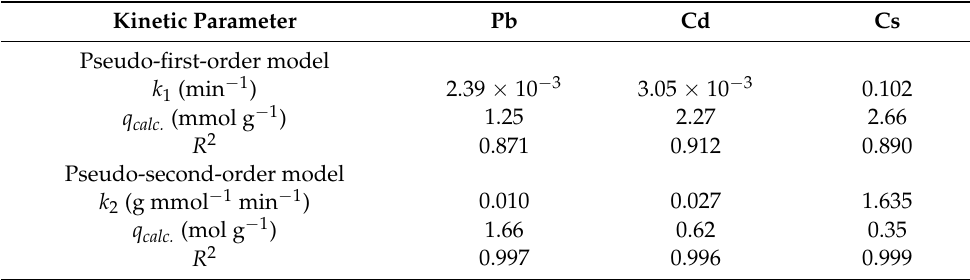
Table 4. Kinetic parameters for the removal of Pb 2+ , Cd 2+ , and Cs + from aqueous solutions by the 7-day hydrothermal product